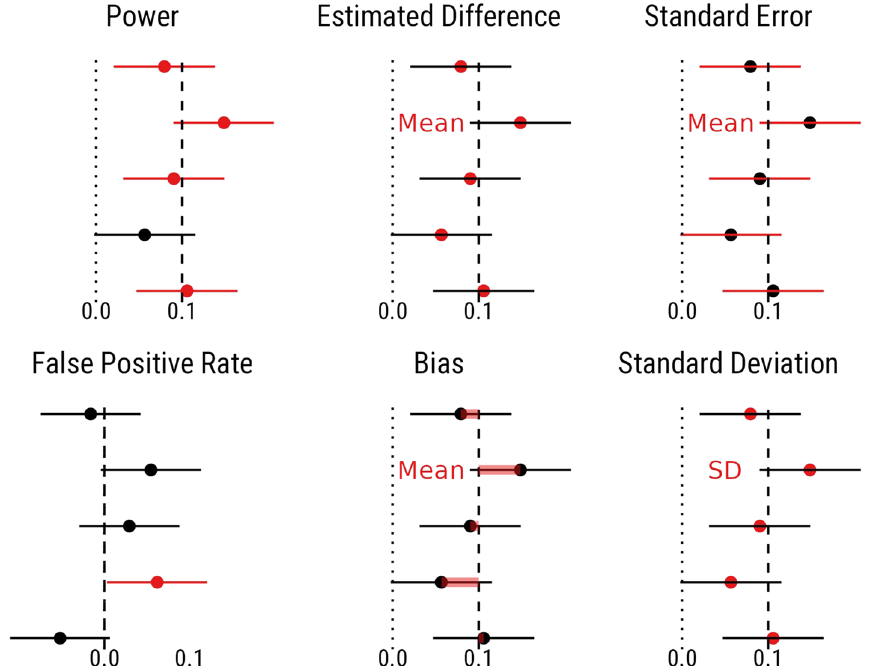
Fig. 3 Summary of the different metrics for evaluating the methods. In each case, the model estimates are depicted for each simulated dataset along the y axis, with the posterior mean and its uncertainty represented by the point and the error bars, respectively, represented on the x axis. Dotted lines represent zero, and dashed lines represent the true values. Red is used to highlight the focus of each metric, of which the mean or standard deviation (SD) is assessed, depicted by red